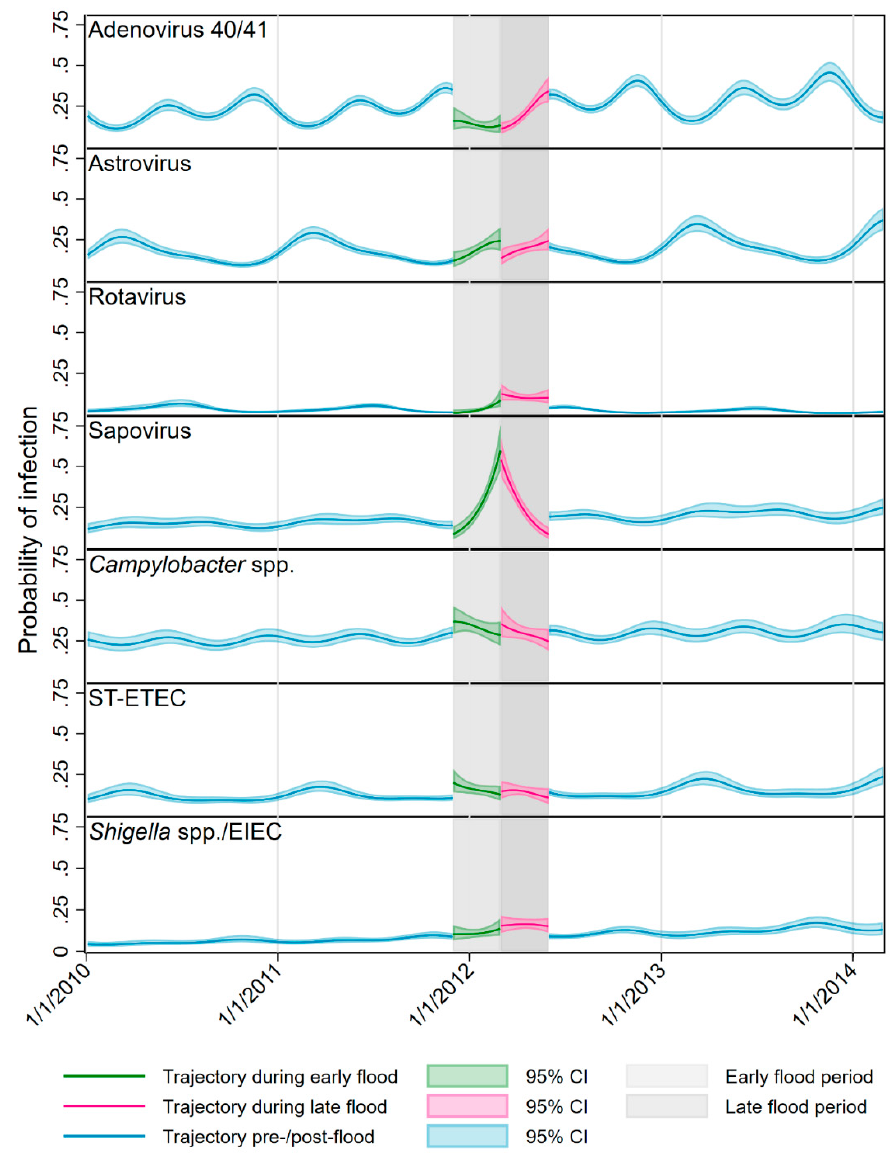
Figure 4. Transmission trajectories predicted by the models with (confidence intervals—CIs) for the seven pathogens that exhibited statistically significant effects (probabilities calculated from relative risk estimates).